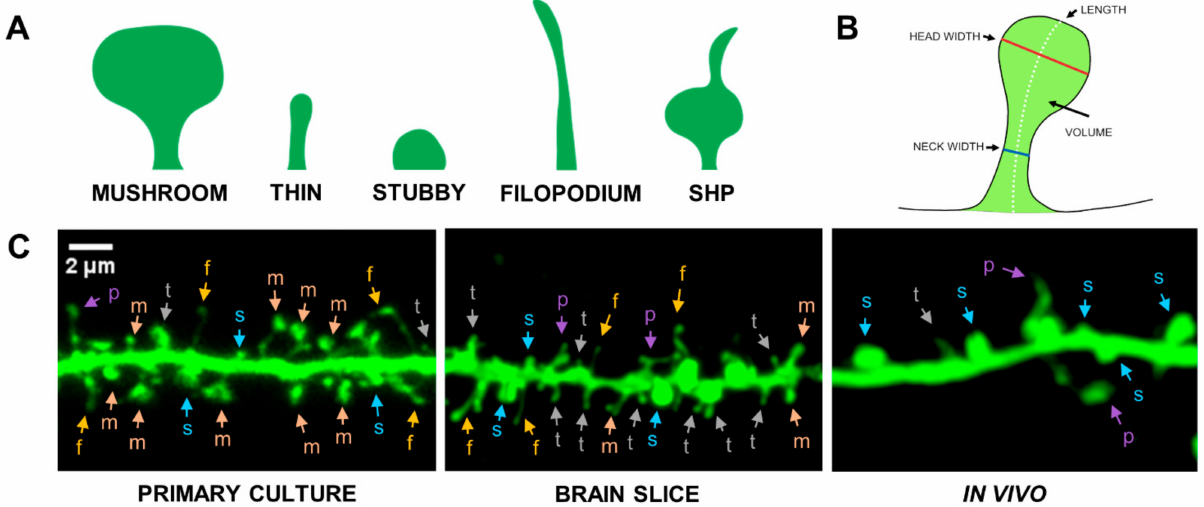
Figure 2. Morphological diversity of dendritic spines. ( A ) Spine shape classification: mushroom (m), thin (t), stubby (s), filopodium (f), SHP-spine head protrusion (p); ( B ) definition of morphometric parameters; ( C ) microscopic images of dendrites covered with dendritic spines obtained from in vitro (primary culture), ex vivo (brain slice), and in vivo (cranial window) imaging. Scale bar: 2 µ